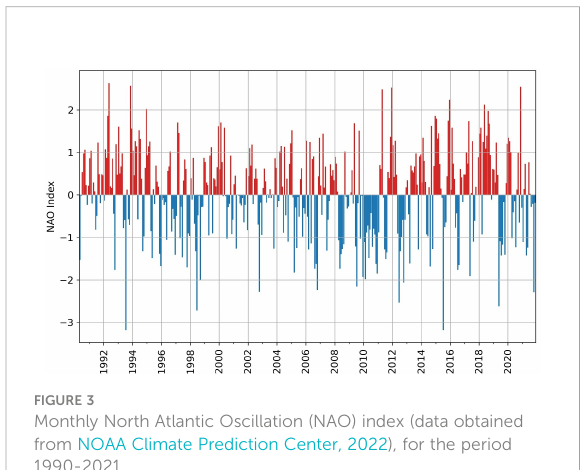
FIGURE 3 Monthly North Atlantic Oscillation (NAO) index (data obtained from NOAA Climate Prediction Center, 2022), for the period 1990-2021.